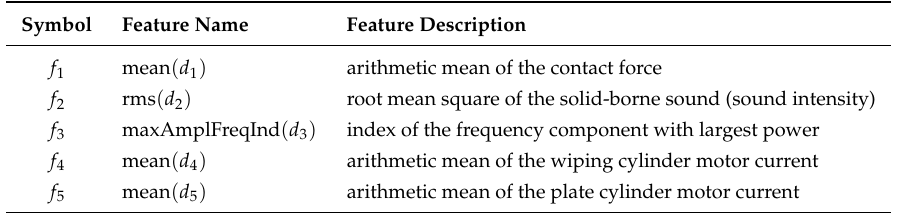
Table A2. Summary of the features extracted from the sensor signals d acquired at the printing unit